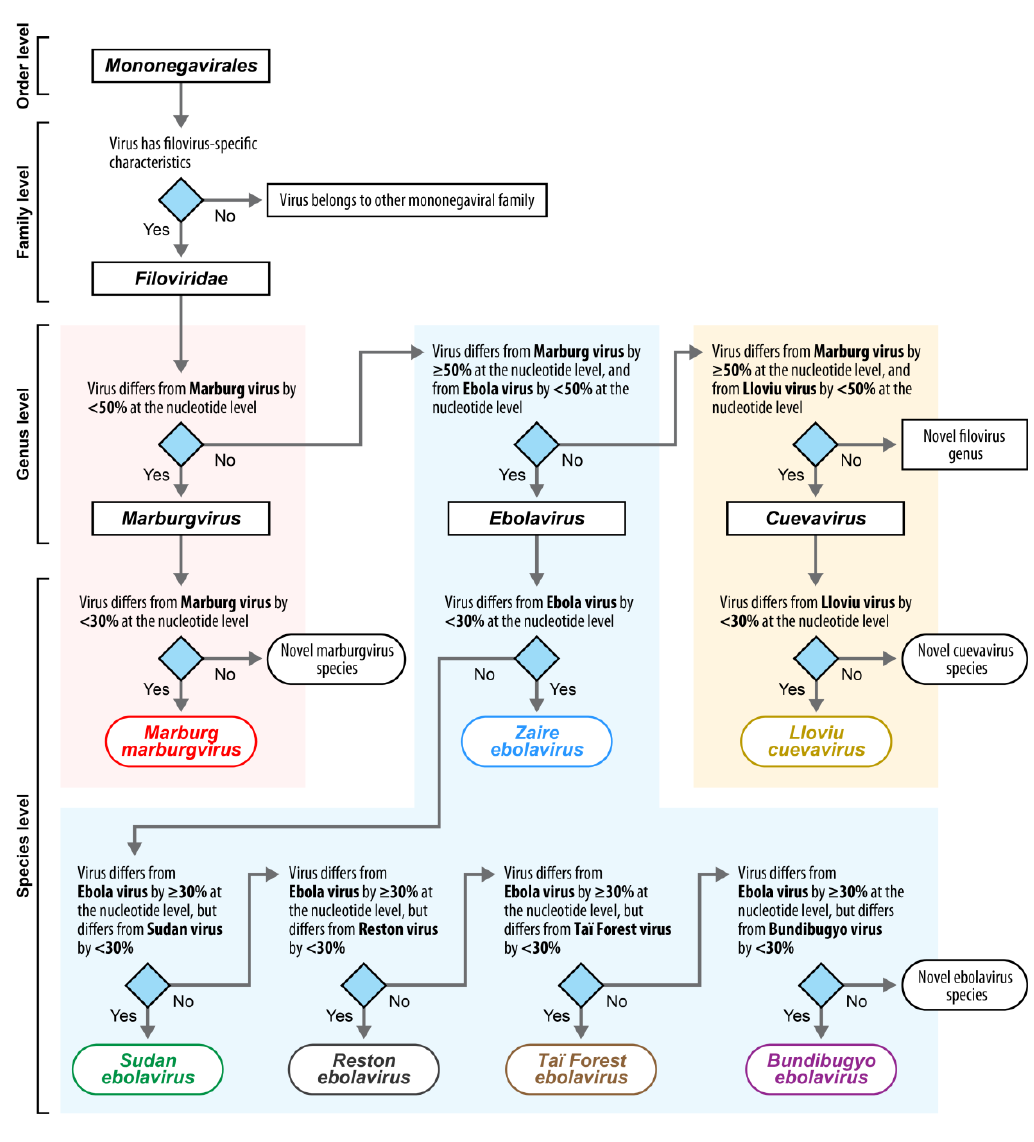
Figure 1. Genome-based classification of novel filoviruses or filovirus genomic